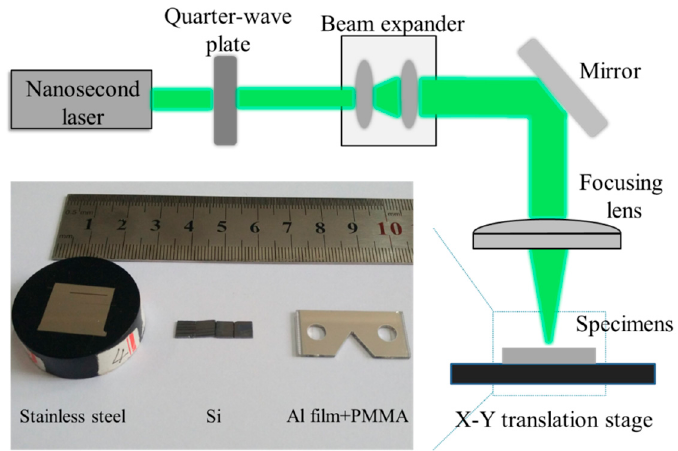
Figure 2. Schematic diagram of a nanosecond laser processing system and the image of specimens.